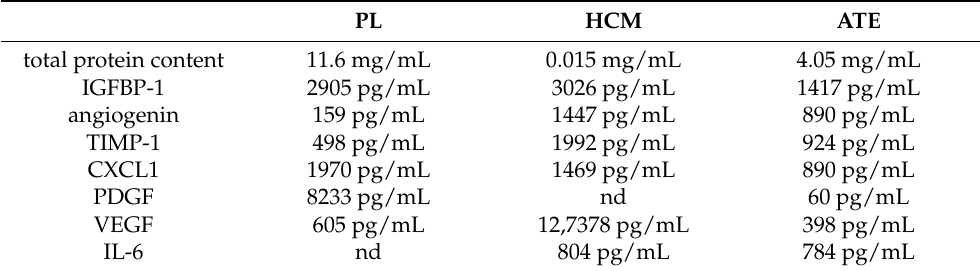
Table 1. The total protein content and concentrations of selected bioactive factors within native, unconcentrated platelet lysate (PL), hypoxia-conditioned medium (HCM) and adipose tissue extract (ATE) as used for this study and reported previously [19] (nd: not detectable). PL total protein